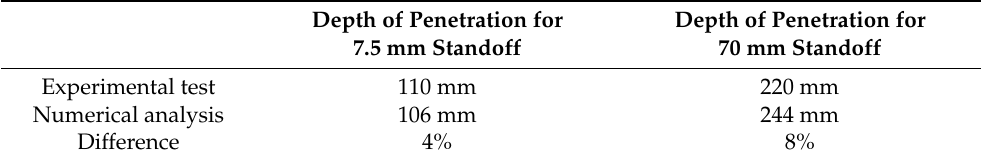
Table 7. The values of the penetration depth of the steel block with the shaped